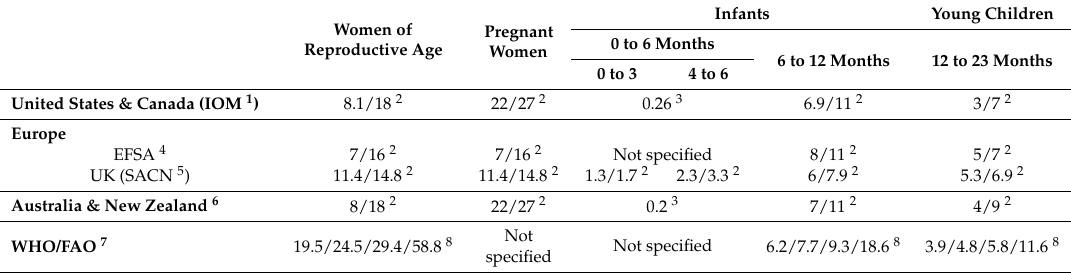
Table 1. Dietary iron reference intake values (mg/day) for pregnant women, infants and young children (12–23 months) in the United States, Canada, Europe, Australia, New Zealand and World. Infants Young Women of Pregnant Reproductive Age Women